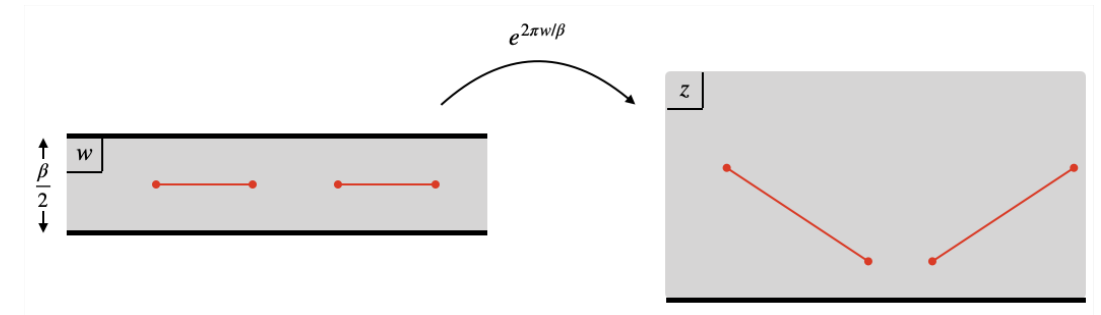
Figure 3 . The conformal map from the in(cid:12)nite strip to the upper half plane used in the evaluation of the global quench. The red dots represent the twist operator insertions and the thick black lines represent boundaries of the